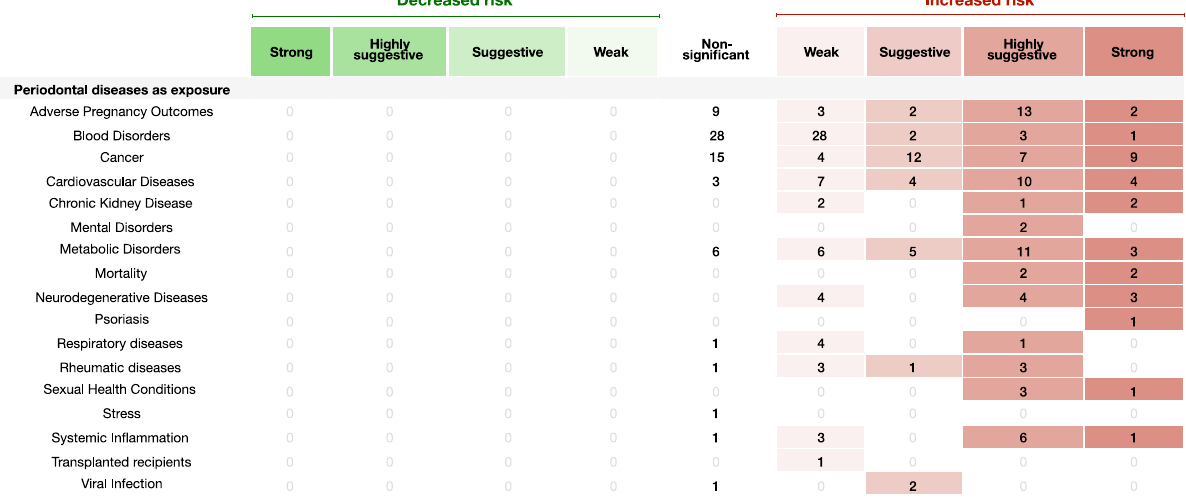
Fig.5|Evidencegradingdiagramonperiodontaldiseasesasanexposuretoan NCD. The right side displays associations that increase the risk for the respective NCD (in red), whereas the left side shows associations that reduce the risk (in